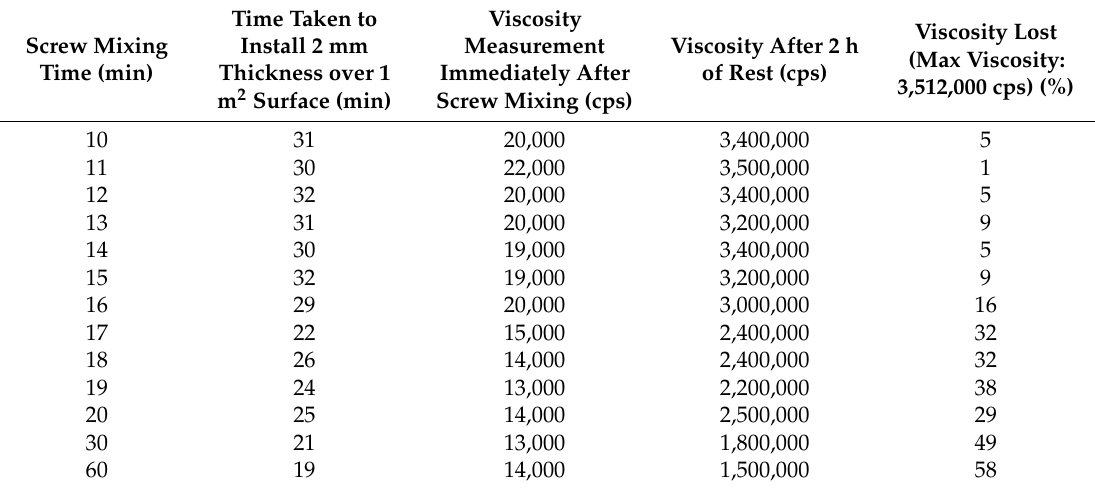
Figure 3. SPRG Gel screw-mixing process prior to application; ( a ) screw mixing SPRG; ( b ) reduced viscosity after mixing. Table 2. Typical SPRG structural component list.